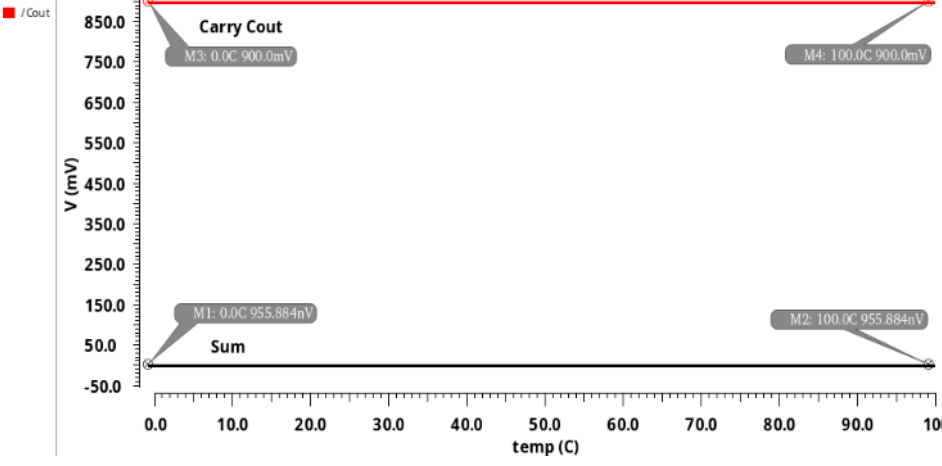
(TGA1) and TGA2 have the maximum delay. The PDP for the 13T AA is 2.043 × 10 − 18 J and for 10T AA is 1.3724 × 10 − 18 J. In comparison of average power (µW), the 10T AA has the